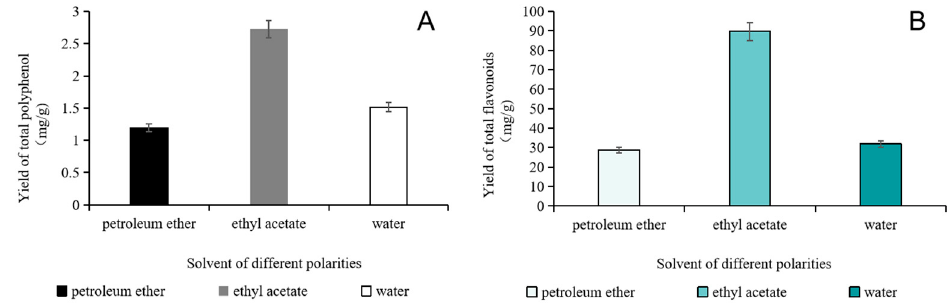
Figure 1. Effect of different extraction solvents on the yield of total polyphenol ( A ) and flavonoids ( B ).